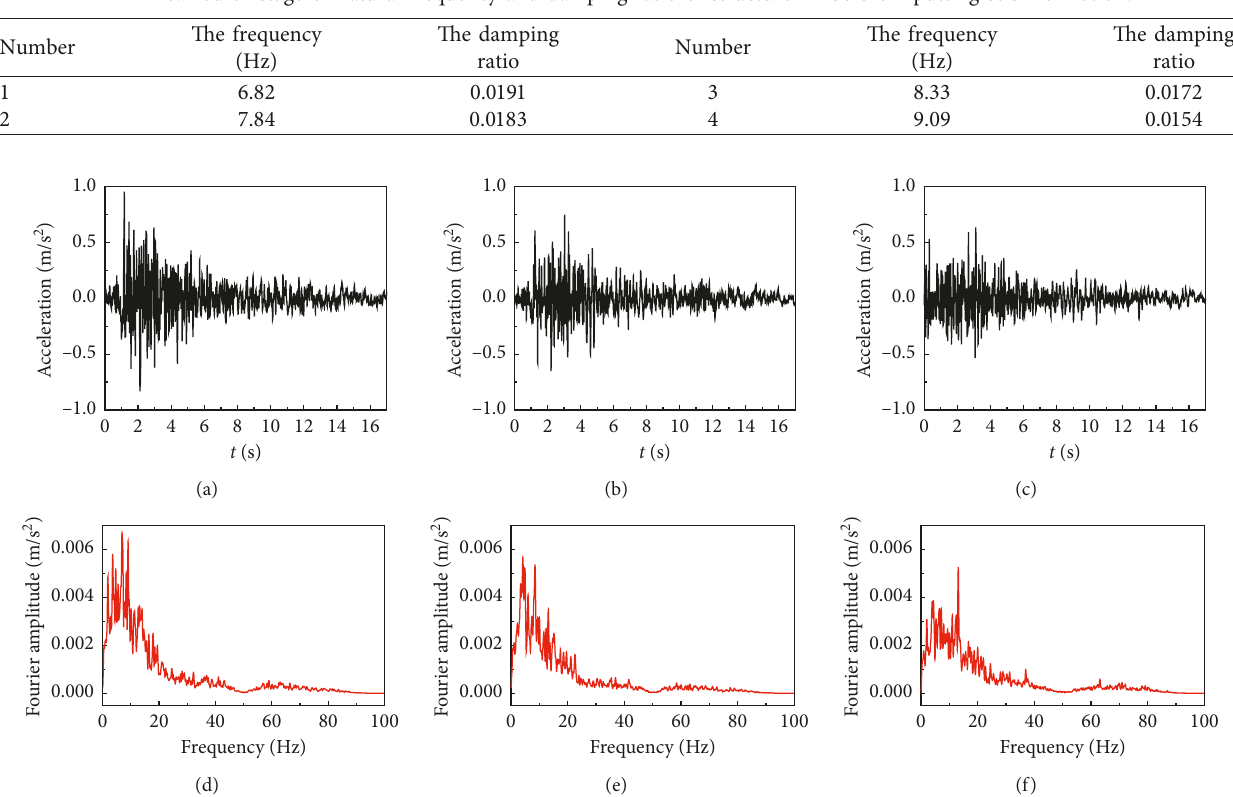
Figure 5: Details of the Taft seismic motion. (a) Time history curve in x direction; (b) time history curve in y direction; (c) time history curve in z direction; (d) Fourier spectra in x direction; (e) Fourier spectra in y direction; (f) Fourier spectra in z direction.